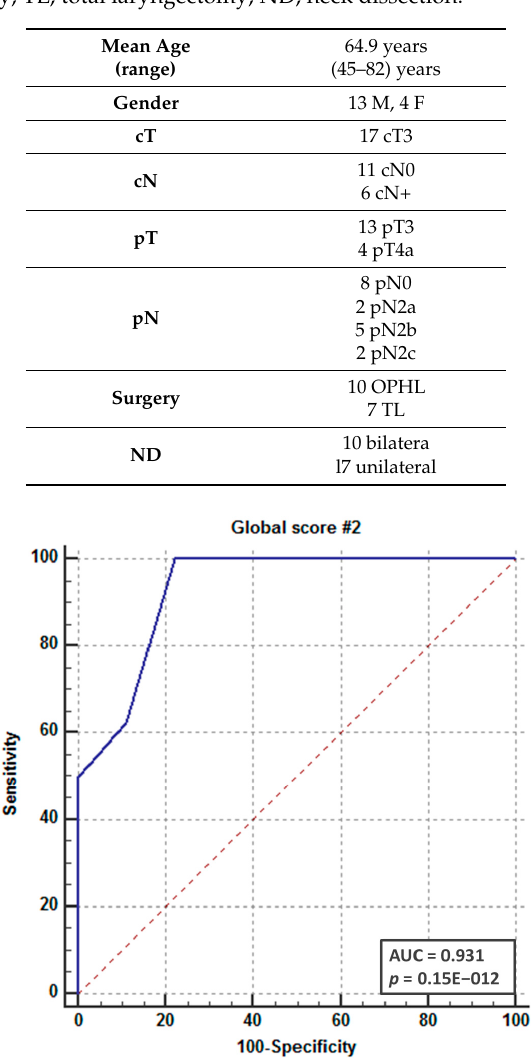
Figure 6. Area under the curve of Partial Score Pattern C. The optimal cut-off value was 2, corresponding to one subsite with Pattern C signal abnormalities.